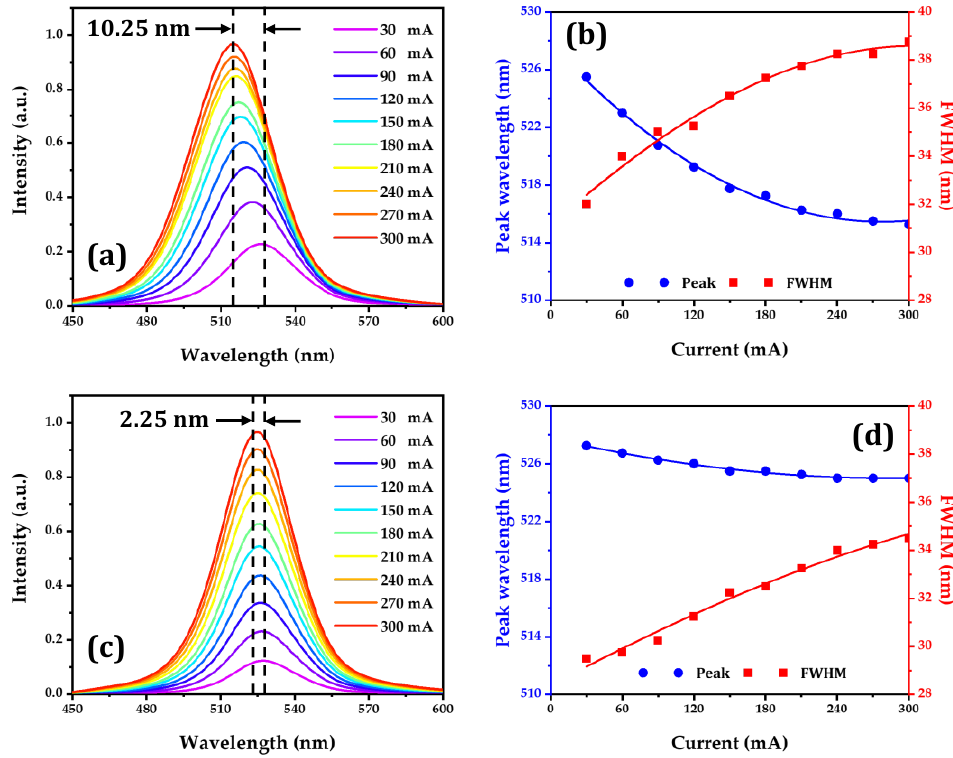
Figure 7. ( a , b ) Electroluminescence spectra, peak wavelength shifts, and FWHMs of the μ-LEDs with regular MQWs. ( c , d ) Electroluminescence spectra, peak wavelength shifts, and FWHMs of the μ-LEDs with staggered MQWs.